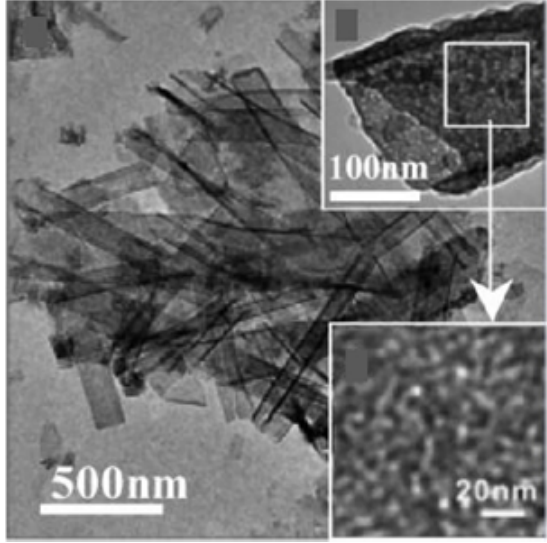
Figure 3: TEM images of nanotubular iron phosphate with meso- porous structure